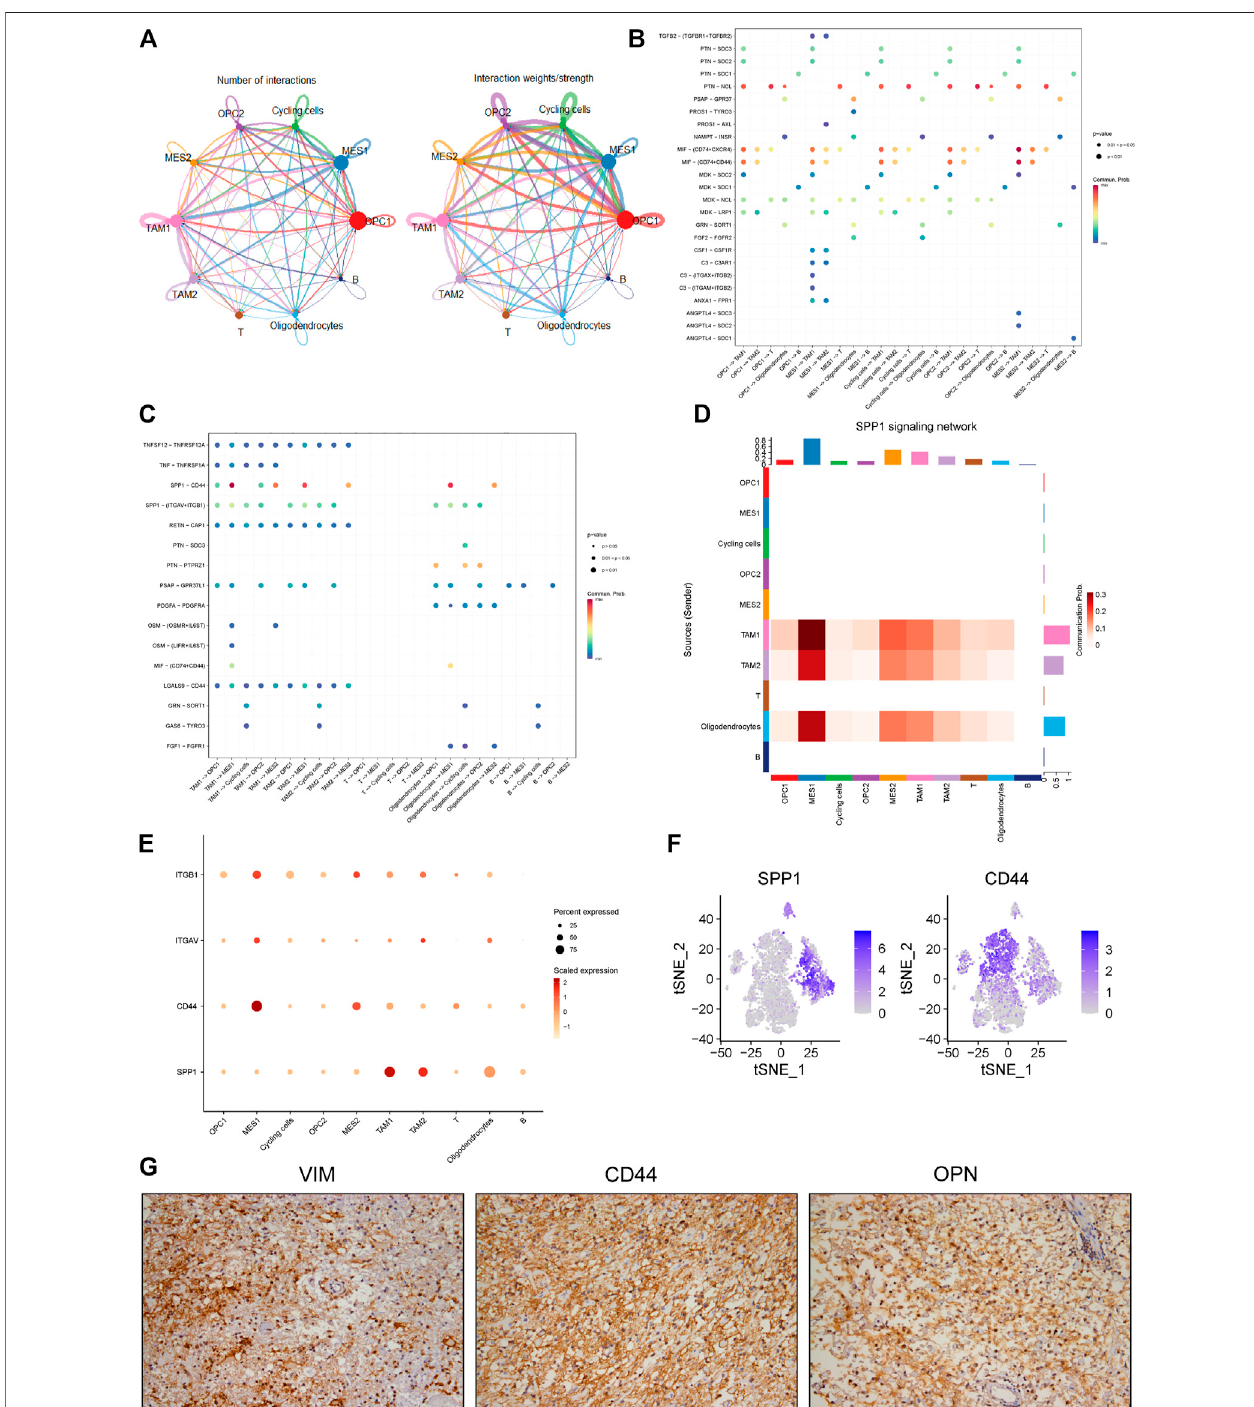
FIGURE5| Identi fi cationofcell-cellinteractionsinagliomaecosystem. (A) Circleplotsdisplayingthenumber(left)andweights(right)ofligand-receptorinteractions between distinct cellular components, respectively. Clusters are distinguished by colors. The circle size is proportional to the number of cells in each cluster, the edge widthrepresentscommunicationprobability. (B-C) Dotplotsshowingtheeffectsoftumorcellsonstromalcells (B) andstromalcellsontumorcells (C) ,respectively.Dot colorsrefer tocommunication probabilities whereasdot sizes represent thecalculated p values. Empty spaceindicates thatthe communicationprobability iszero. The p valuewascalculatedbyone-sidedpermutationtest. (D) HeatmapshowingtheSPP1-relatedsignalingnetworks. Y axisreferstocellsthatsendthesignal,whereas x axisreferstocellsthatreceivethesignal.Thecolorbarrepresentsthecommunicationprobability.Thecolumnsontheupperandrightsidesrefertotheaccumulationof the signal intensity of the y and x axis, respectively. (E) The dot plot showing the expression levels of representative genes (ITGB1, ITGAV, CD44 and SPP1) in the SPP1 signaling network. The color bar represents the signal intensity. (F) The t-SNE plot showing the SPP1 and CD44 expression levels in all cells of this glioma. (G) The representative images of IHC staining for VIMENTIN, CD44 and OPN proteins in the glioma tumor. Scale bars, 100 μ M.